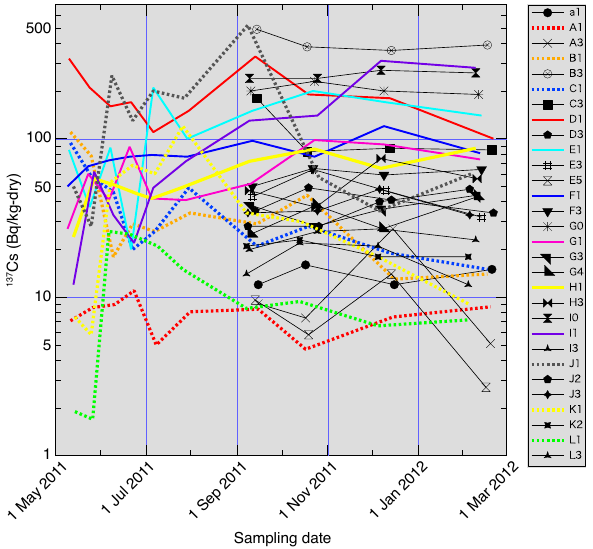
Fig. 4. Temporal variations of 137 Cs concentrations in the sed- iments. Six sediment samples were collected at Stn. D1 on 13 September 2011, and the average of the six concentrations is plotted in the figure (see Sect. 3.1 and Fig. 5).